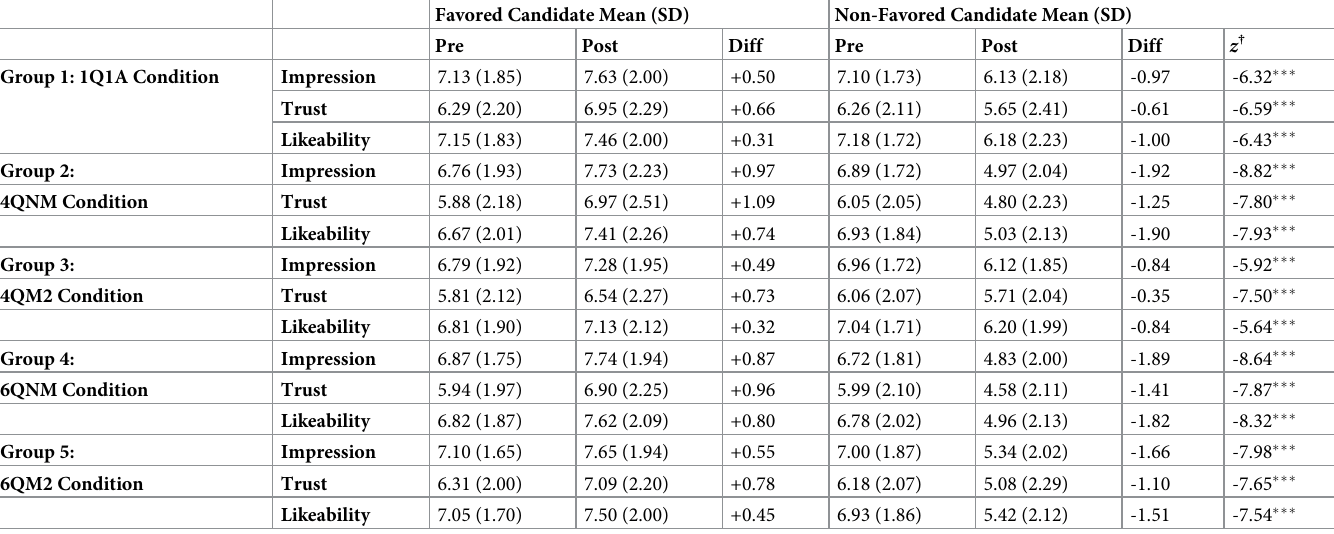
Table 6. Experiment 3: Pre- and post-IPA opinion ratings of favored and non-favored candidates.